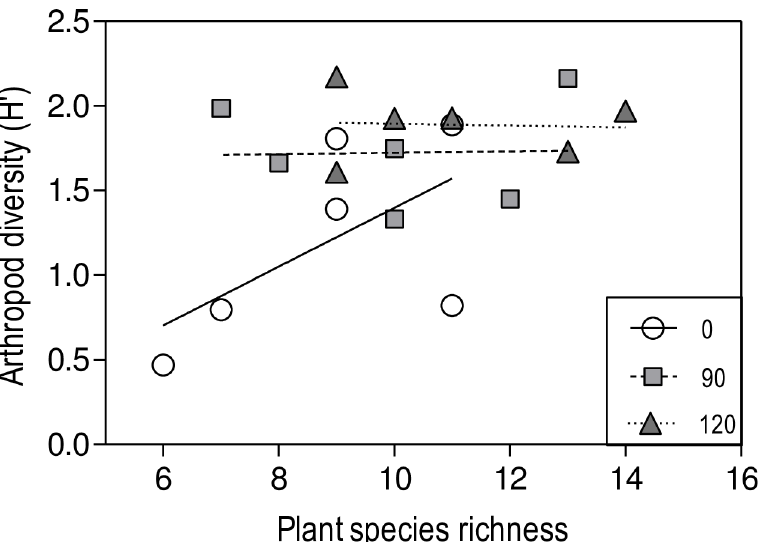
Fig 3. Relationship between the arthropod diversity (Shannon index H´) and the number of plant species. Plant species were recordedin the field plots where soil seed bank selectedunder different episodic ozoneconcentrations [0 (white circle), 90 (grey square) and 120 (black triangle)ppb] was sown. Arthropods naturallycolonizedthe plots. Each data point corresponds to one plot coming from a particularozone concentration in one of two years of experiment. Spearman´scorrelation0 ppb r s = 0.71, n = 6, P < 0.01; 90 ppb r s = 0.02, n = 6, P = 0.75; 120 ppb, r s = 0.10, n = 6, P = 0.68